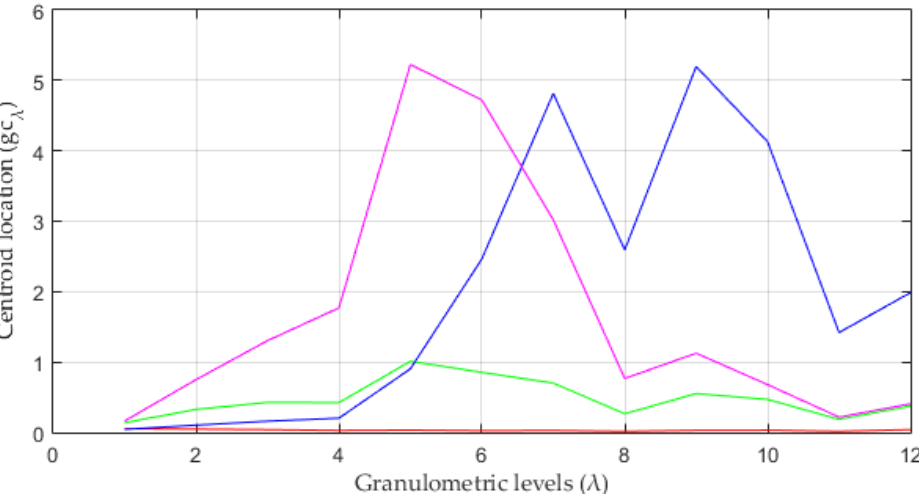
Figure 8. Granulometric profiles of 4 classes from 12 granulometric levels. Guileyni, 1975.